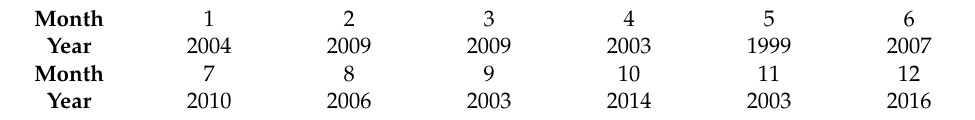
Table 1. Selected typical meteorological year.